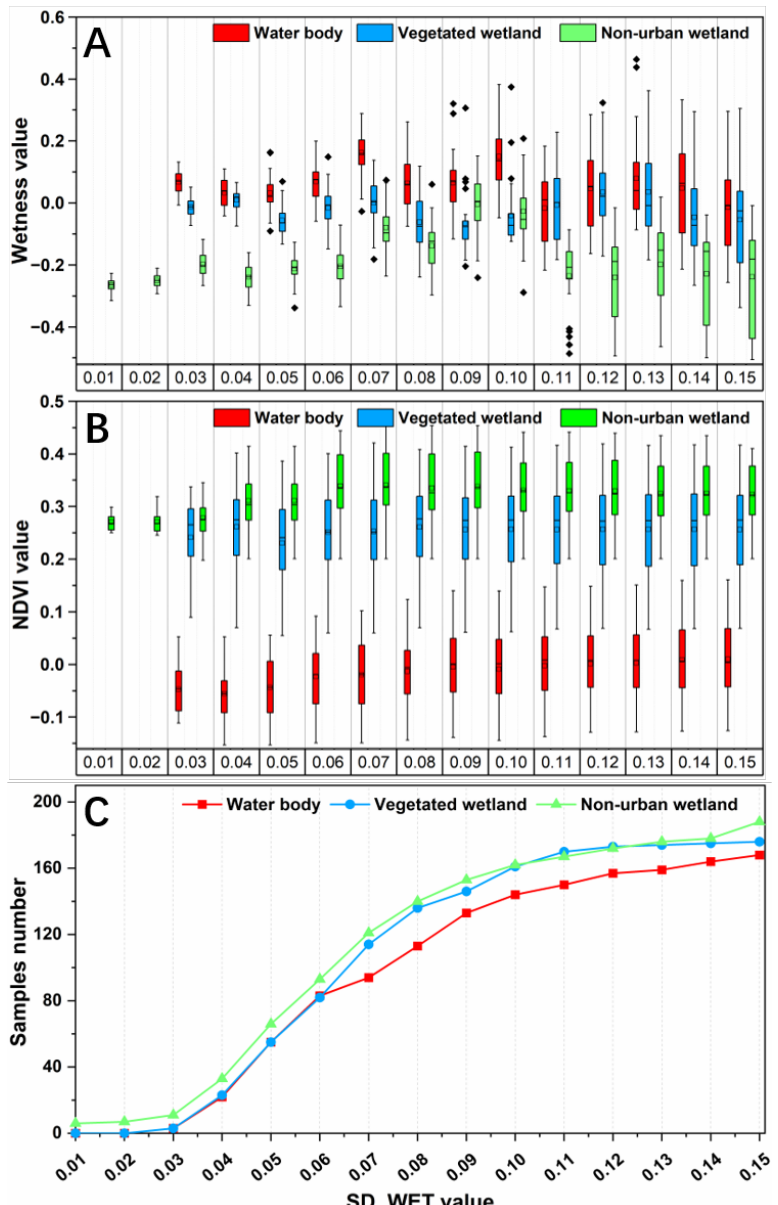
Figure 6. The variation characteristics of the time series wetness ( A ) and NDVI ( B ) for each type of sample with different SD_WET values. ( C ) shows the changes of sample number with different SD_WET values.